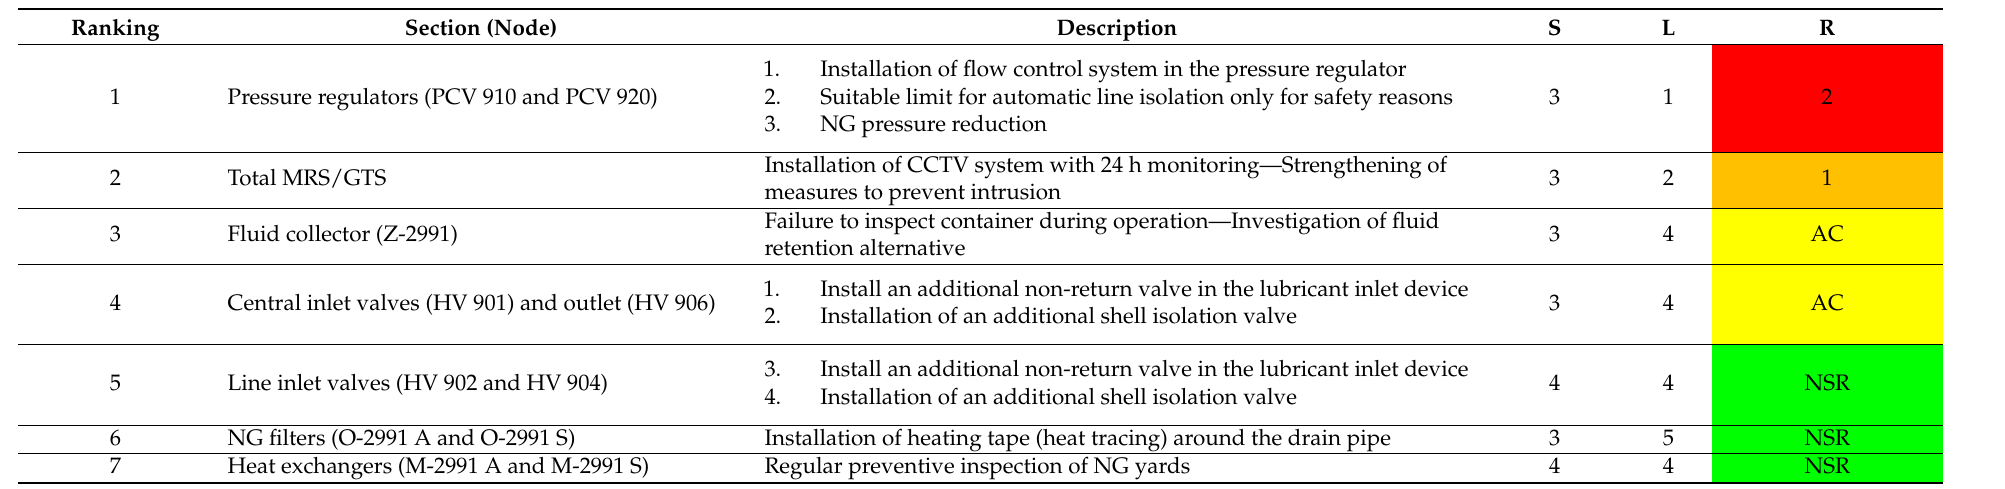
Table 10. HAZOP results along with the risk ranking by the DMRA for the